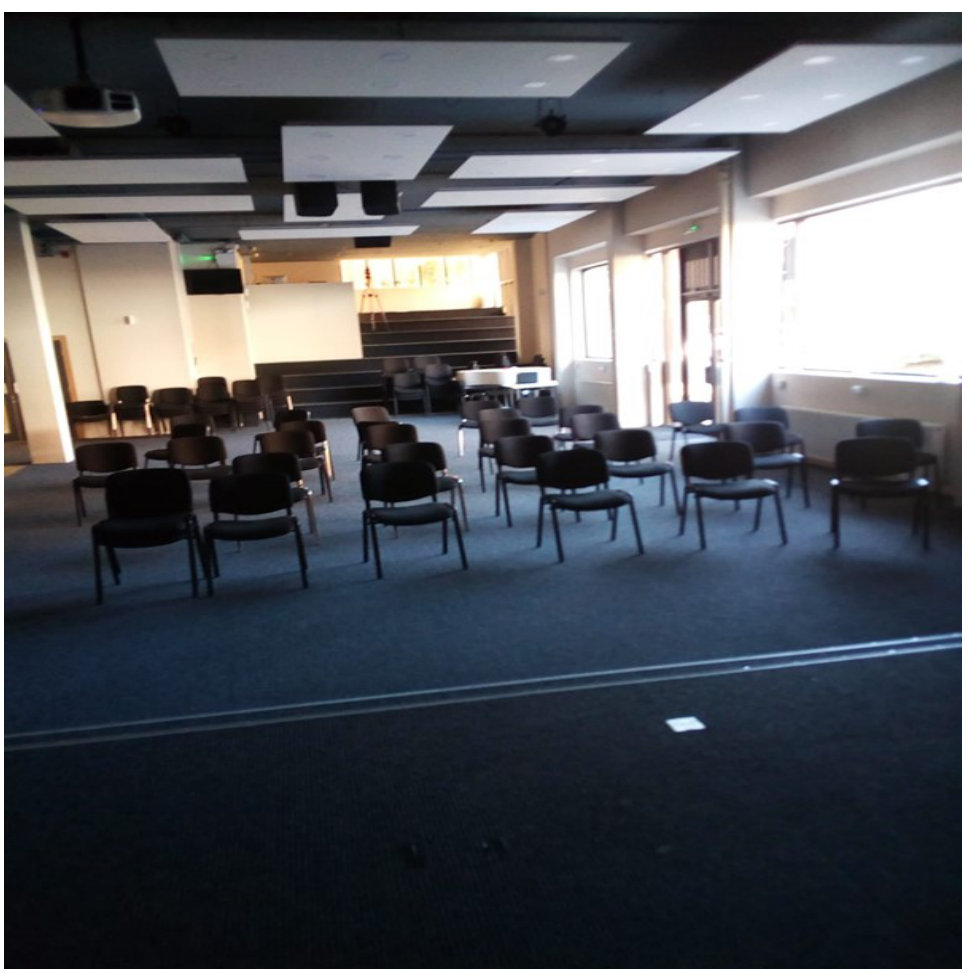
Figure 2. A random sample picture of the data collection